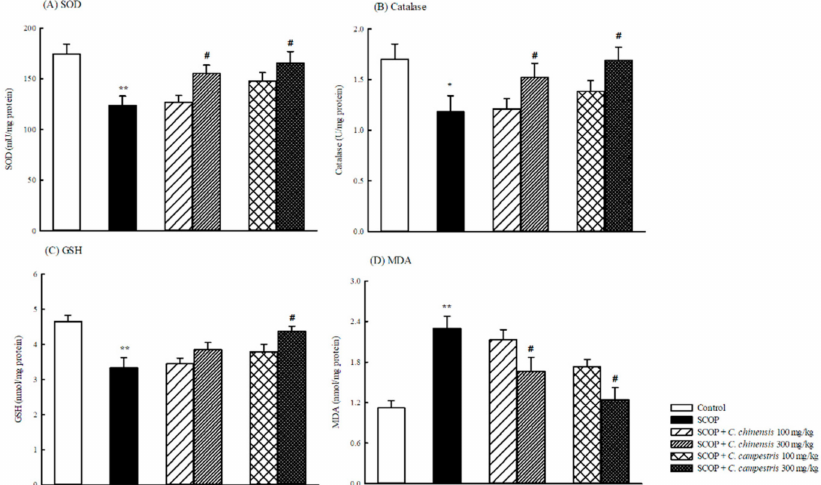
Figure 6. The effects of Cuscuta chinensis and C. campestris extracts (100 and 300 mg/kg, po) on ( A ) brain superoxide dismutase (SOD) activities, ( B ) brain catalase activities, ( C ) brain glutathione (GSH) levels, and ( D ) brain malondialdehyde (MDA) levels in scopolamine (SCOP, 1 mg/kg, ip)-treated mice. All the brain tissues were collected from the tested mice and then homogenized to obtain the total brain homogenates. The SOD and catalase activities and the GSH and MDA levels in the total brain homogenates were subsequently examined. Columns indicate mean ± SEM ( n = 7). * p < 0.05, ** p < 0.01 compared with the control group. # p < 0.05 compared with the SCOP